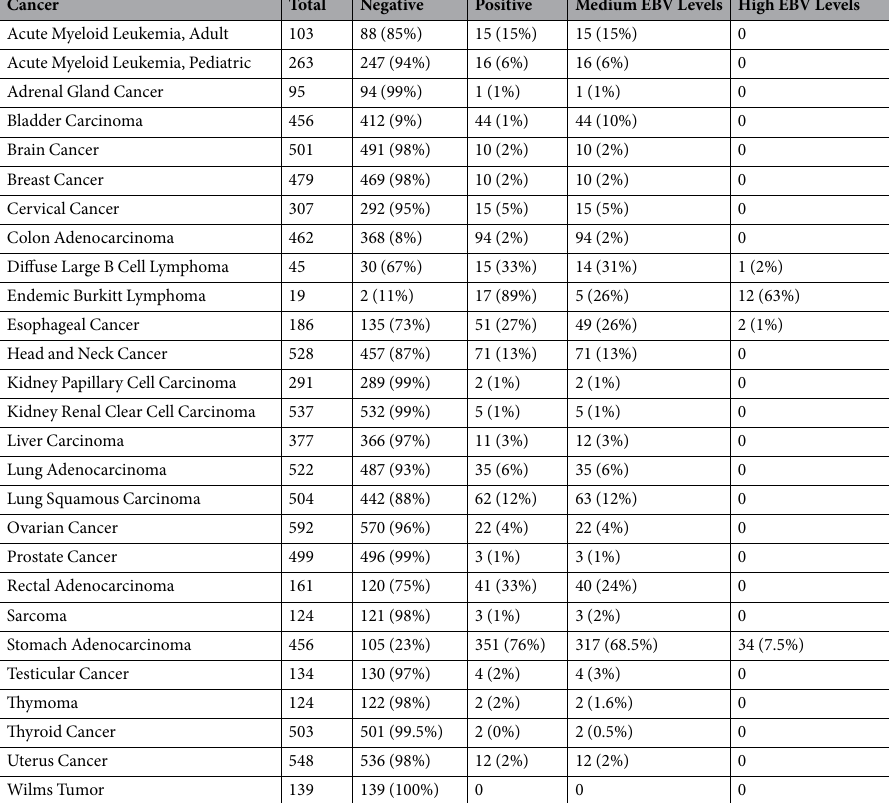
Table 1. EBV miRNA levels for each cancer type. Positive samples are samples with ≥ 10 counts per million (CPM) of viral miRNA and EBER expression. Negative samples are those with ≤ 10 CPM of viral miRNA and EBERs levels. Green lines signify cancers samples previously associated with Epstein Barr Virus (EBV). The first number on each cell of “number of samples with medium/high EBV level”, and the second number in the parenthesis represents “the percent of the latter samples”.